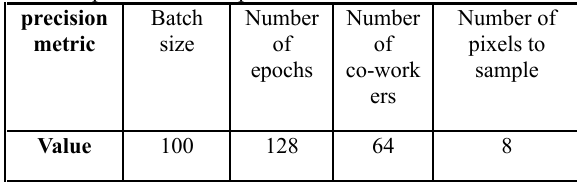
Figure 10. Sensitivity of the batch size on the performance of the model